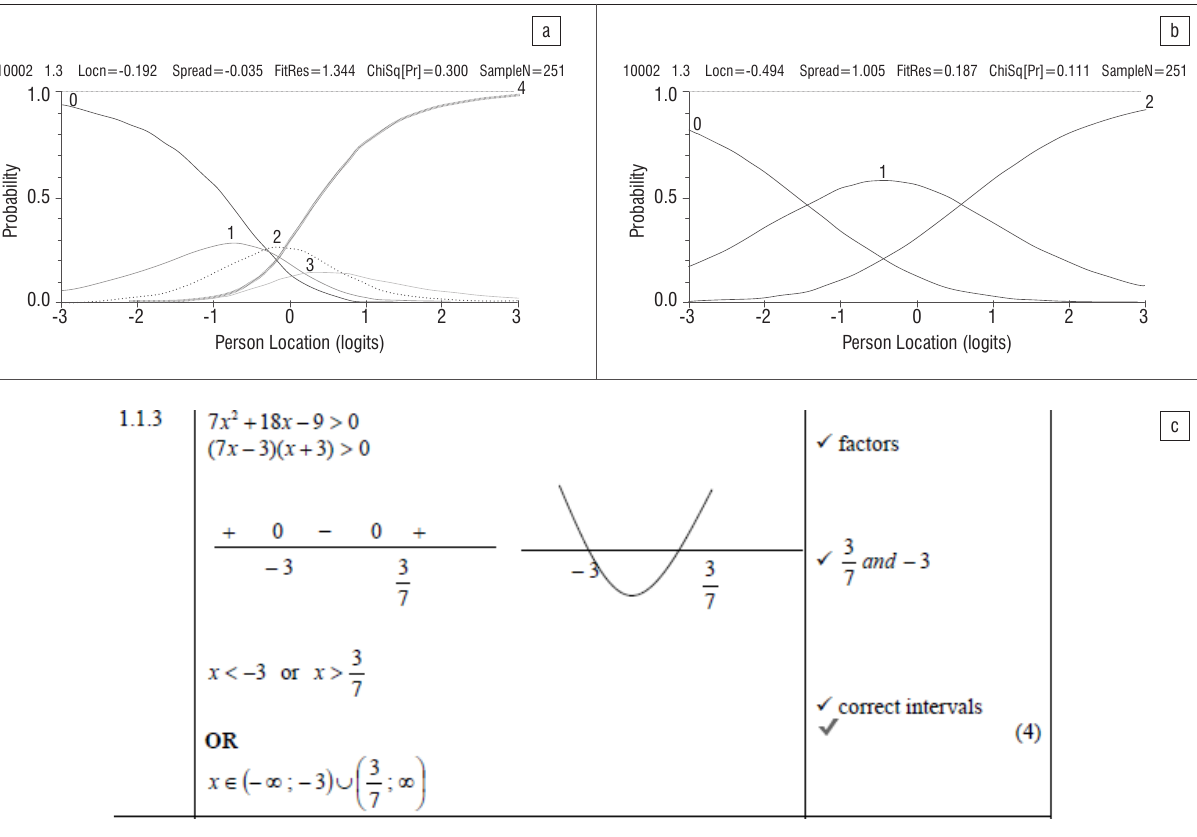
Figure 7: (a) Initial and (b) final category probability curves and (c) the marking memorandum for Item